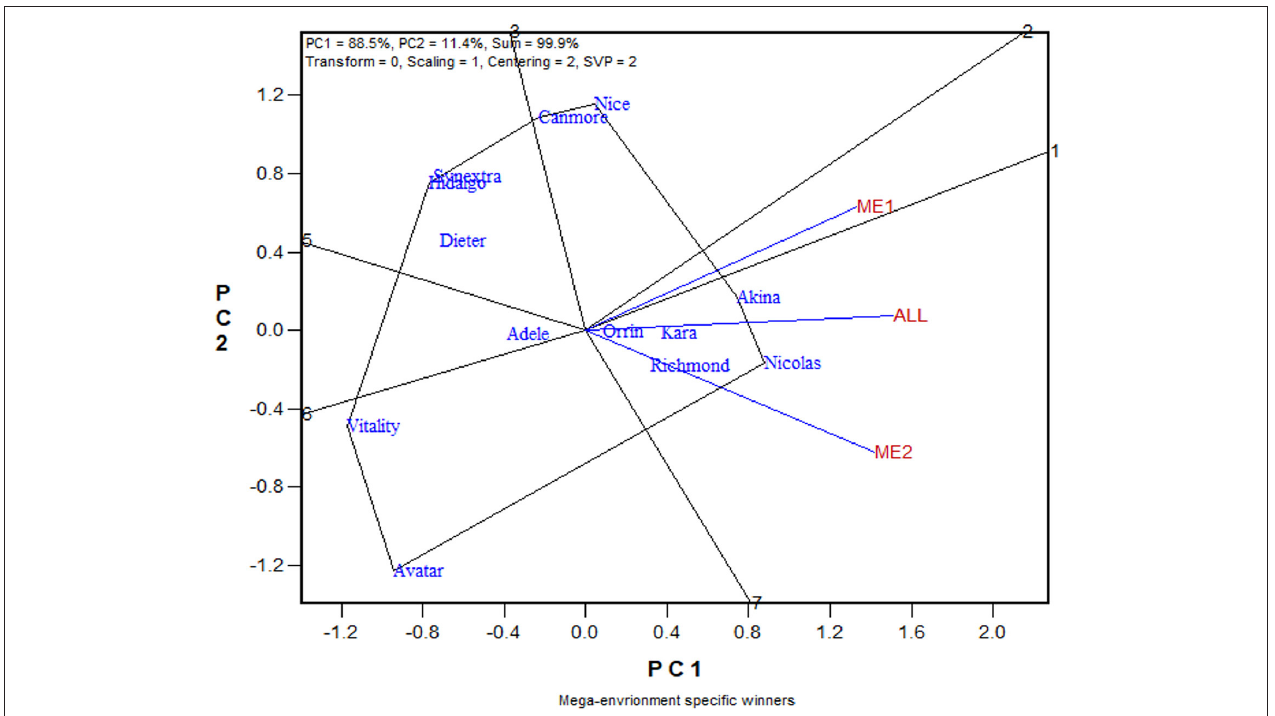
FIGURE 7 | The which-won-where view of the GGE biplot to show the relative yield of 13 oat cultivars in mega-environment 1 (ME1), mega-environment 2 (ME2), and the undivided Quebec oat growing regions (ALL). The polygon was formed by connecting the genotypes that are placed away from the biplot origin in all directions. For each polygon side a line perpendicular to it was drawn from the biplot origin. These lines dissect the biplot into sectors. For each sector, the genotype at the vertex is the nominal highest yielder for the environments or mega-environments fell in it. In this case, Akina was the highest yielder in ME1 while Nicolas was the highest yielder in both ME2 and